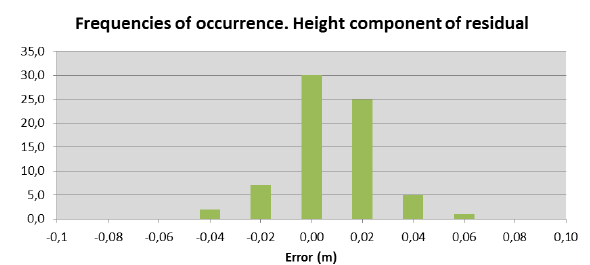
Figure 16. Frequency histogram of the height deviations of natural control points positions The mean and standard deviation for each discrepancy component, assuming that the data have a normal distribution, are reported in table 5.